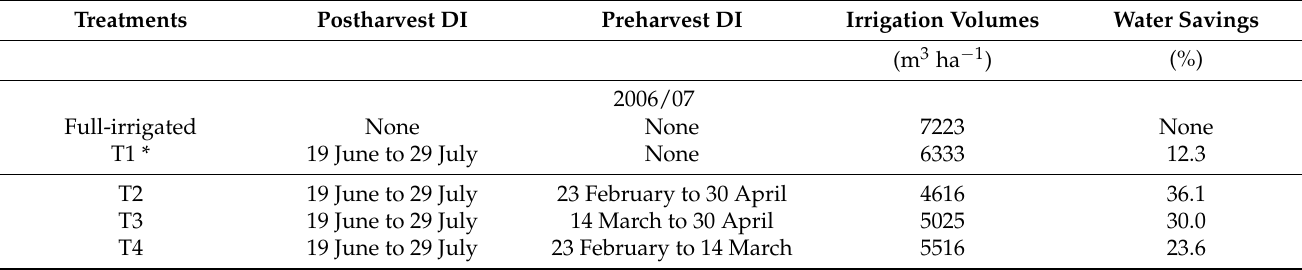
Table 1. Description of the different irrigation treatments: periods of application of postharvest (preflowering) and preharvest DI (no irrigation) including dates, irrigation volumes applied and water savings achieved. Treatments Postharvest DI Preharvest DI Irrigation Volumes Water Savings (m 3 ha − 1 ) 2006/07